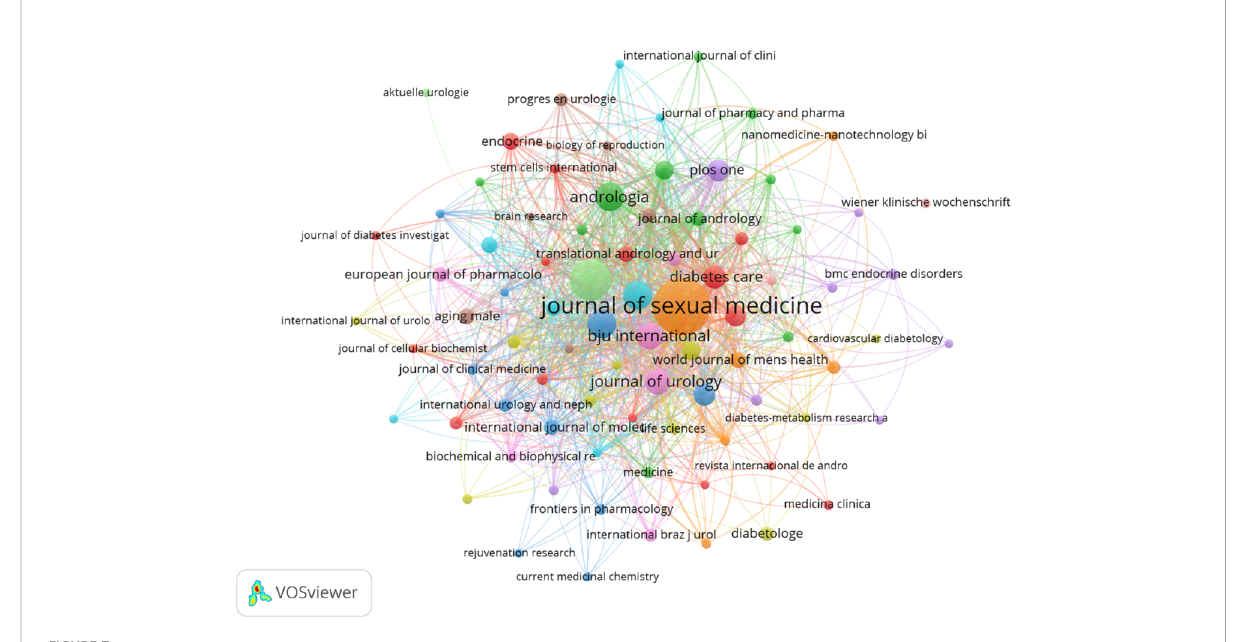
FIGURE 7 Analysis of cited